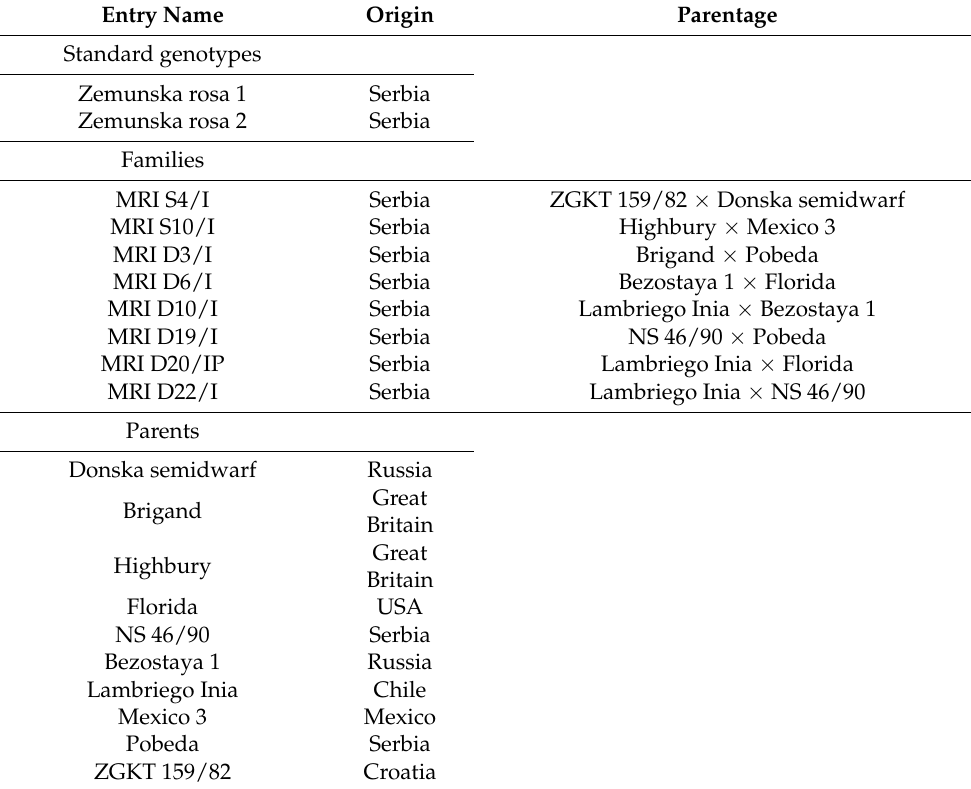
Table 1. Name and origin of 20 wheat genotypes analyzed, with parentage for F6:7 families.